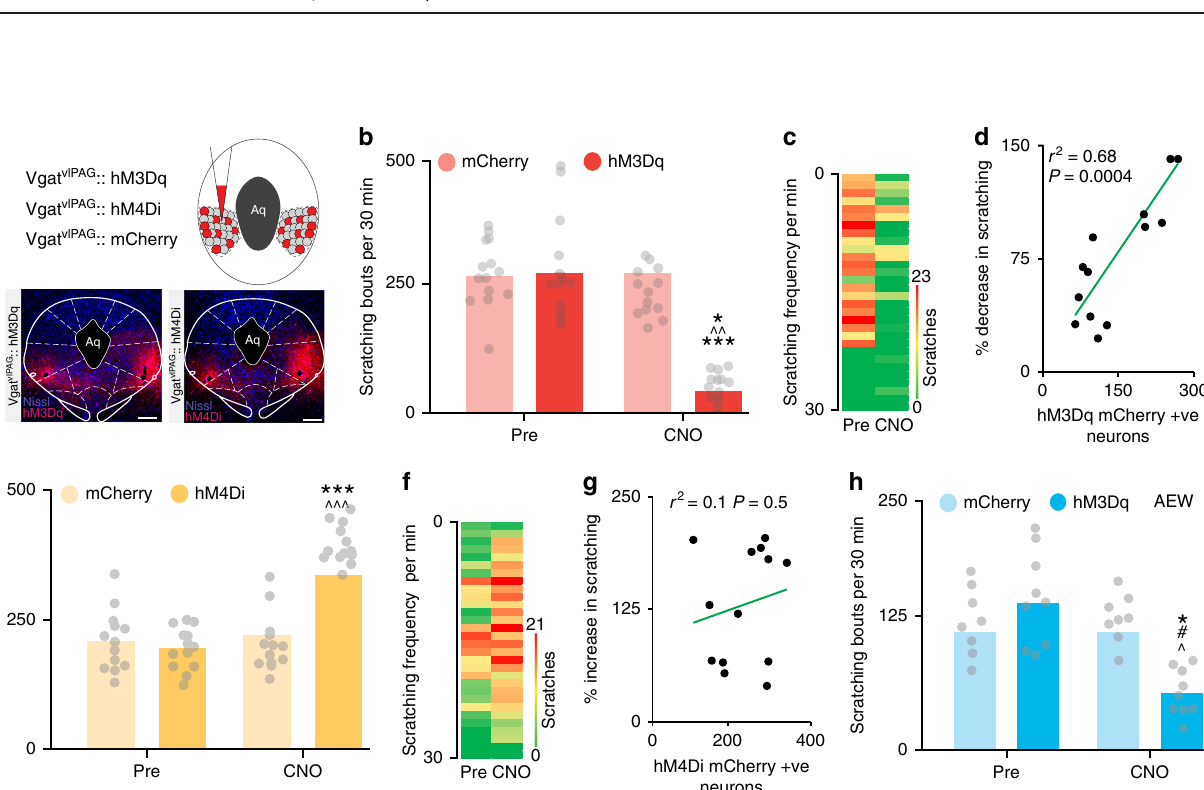
Fig. 4 Ca2 + dynamics of vlPAG cell-types in itch processing. a Schematic and representative coronal section image showing viral targeting of AAVDJ GCaMP6s injected into the vlPAG in the Vgat and Vglut2 Cre mice. b Illustration of fi ber photometry setup. c Averaged GCAMP6s fl uorescence signal of Vgat + ve and Vglut + ve vlPAG neurons showing changes in fl uorescence after initiation of scratching bout. Trace plotted as mean ± SEM (shaded trace), dark shaded line indicates scratching bout. d Averaged Z score for chloroquine-evoked scratching resulted in signi fi cant decrease in the vlPAG GCAMP6s fl uorescence in the Vgat + ve neurons. ( N = 3 mice, t test, t = 10.07, df = 4, *** P < 0.0001). e Area under the curve shows signi fi cant decrease in the vlPAG GCAMP6s fl uorescence after chloroquine-evoked scratching in the Vgat + ve neurons. ( N = 3 mice, t test, t = 2.435, df = 4, * P < 0.05. f Averaged Z score for chloroquine-evoked scratching resulted in signi fi cant increase in the vlPAG GCAMP6s fl uorescence in the Vglut + ve neurons. ( N = 3 mice, t test, t = 5.875, df = 4, ** P < 0.0001). g Area under the curve shows signi fi cant increase in the vlPAG GCAMP6s fl uorescence after chloroquine-evoked scratching in the Vglut + ve neurons. ( N = 3 mice, t test, t = 5.964, df = 4, ** P < 0.01. ( h ) Heat map of Ca 2 + dynamics of Vgat + ve vlPAG neurons pre and post chloroquine evoked scratching bouts. Dark shaded line indicates scratching bout. i Heat map of Ca 2 + dynamics of Vglut + ve vlPAG neurons pre and post chloroquine evoked scratching bouts. Dark shaded line indicates scratching bout. j Averaged GCAMP6s fl uorescence signal of Vgat + ve vlPAG neurons after initiation of grooming bout. Trace plotted as mean ± SEM (shaded trace). k Averaged GCAMP6s fl uorescence signal of Vglut + ve vlPAG neurons after initiation of grooming bout. Trace plotted as mean ± SEM (shaded trace), dark shaded line indicates grooming bout. l Averaged GCAMP6s fl uorescence signal of Vgat + ve vlPAG neurons for arbitrarily generated bouts. Trace plotted as mean ± SEM (shaded trace). m Averaged GCAMP6s fl uorescence signal of Vglut + ve vlPAG neurons for arbitrarily generated bouts. Trace plotted as mean ± SEM (shaded trace), dark shaded line indicates arbitrary bout. All values are mean ± SEM. P < 0.0001. Scale bars represents 250 µ M. Source data are available as a Source Data fi le